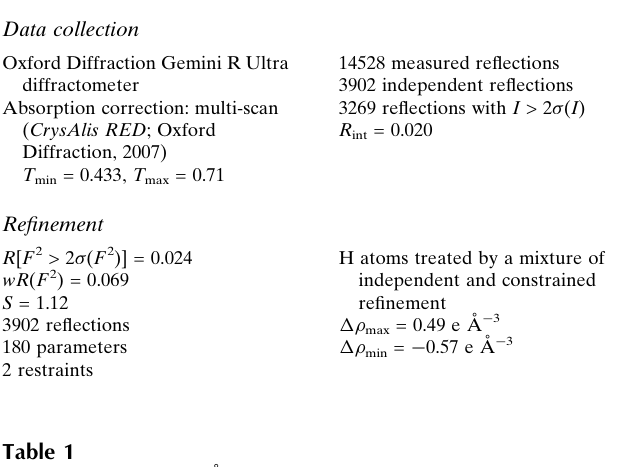
Selected bond lengths (A˚ ).